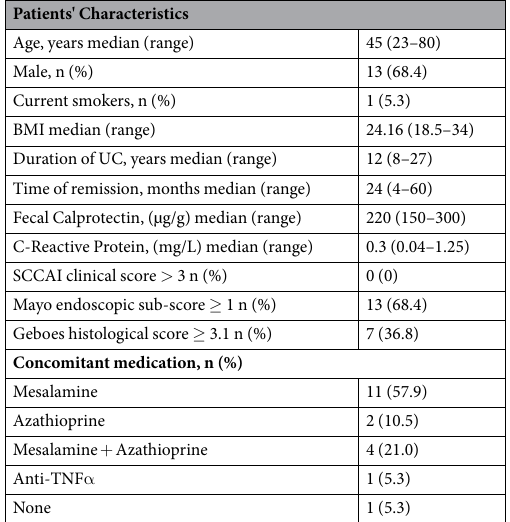
Table 1. Clinico-pathological characteristics of patients at baseline (T0; n =